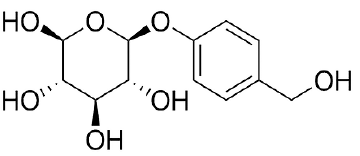
Figure 1. Chemical structure of Gas; molecular weight is 286.3; molecular formula is C 13 H 18 O 7 .